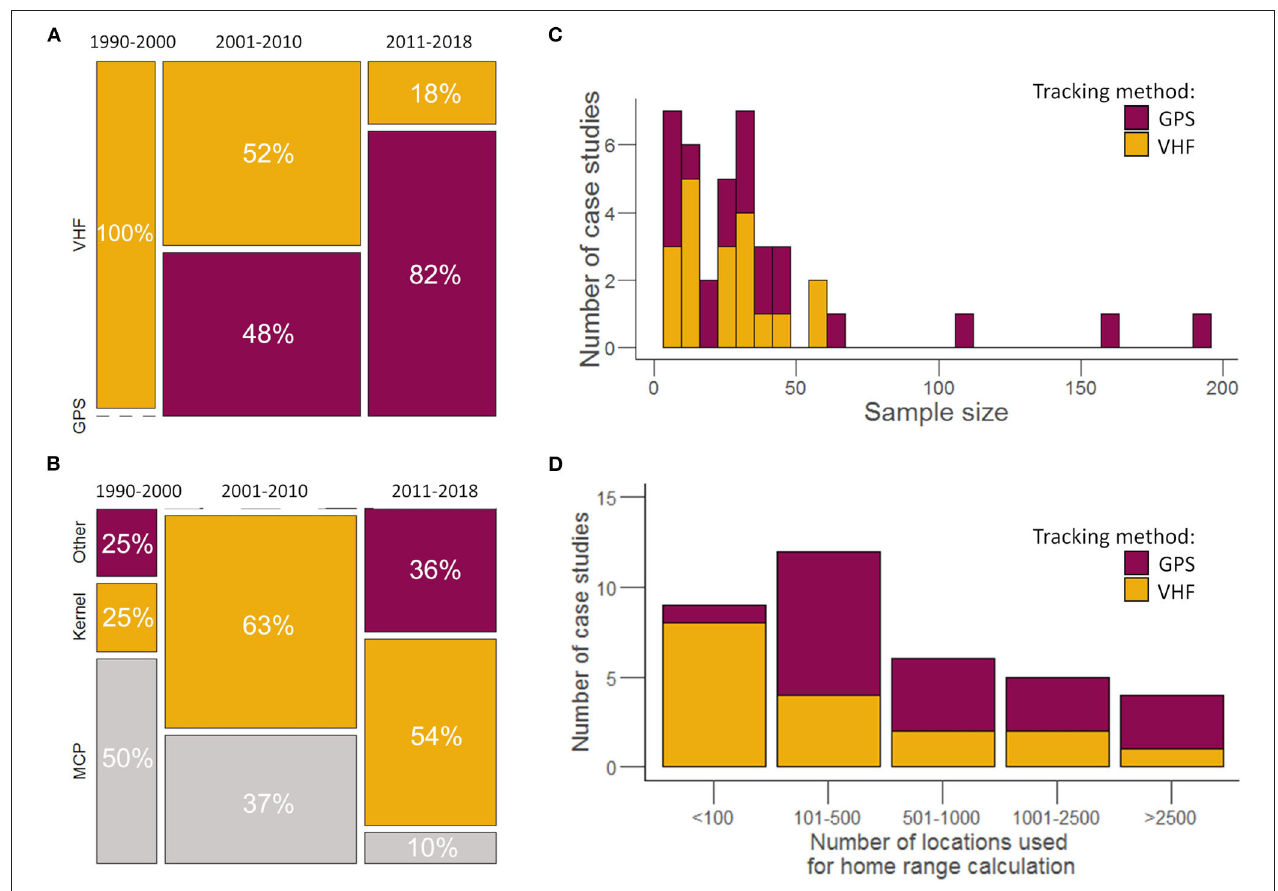
FIGURE 4 | (A) Evolution of tracking methods used in the 33 selected articles (GPS, VHF) according to a 10-year time period. The width of the bars corresponds to the percentage of articles by time period. The percentages given in the bars represent the percentage of articles with data collected with GPS vs. VHF per time period. (B) Evolution of home range estimators used in the 33 articles according to time period. The percentages correspond to the proportions of articles per time period for each home range estimator. (C) Distribution of the number of individuals per case study ( n = 39) according to tracking method. (D) Distribution of the number of locations used for home range calculation in the 39 case studies according to the tracking